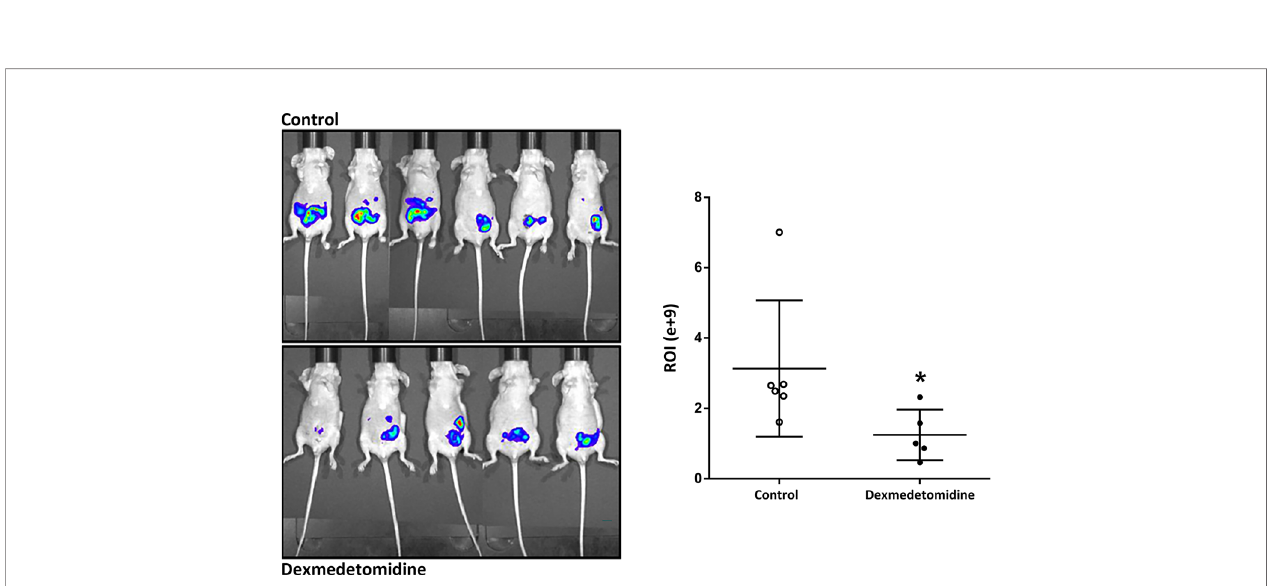
FIGURE 5 | Cancer cell expression observed with in vivo Imaging system at 4 weeks after surgery. * P < 0.05 compared to Control. Error bars represent standard